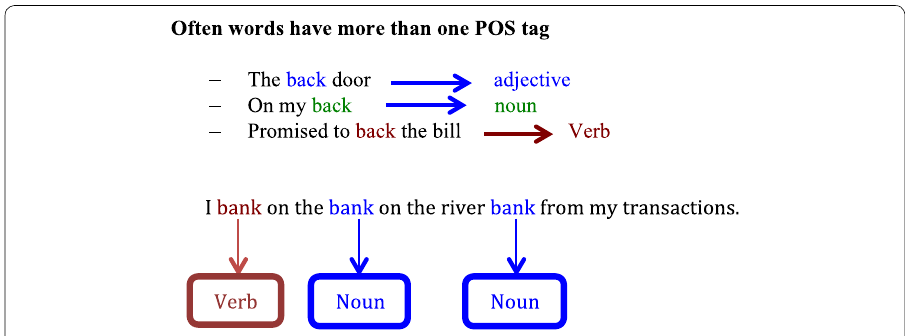
Fig. 4 Words with more than one POS tag